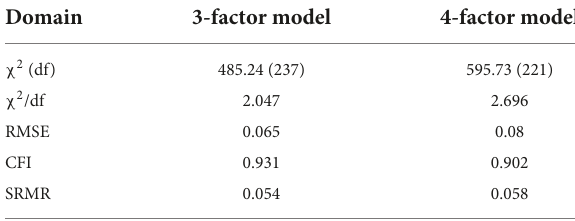
TABLE 3 Goodness-of-fit indices of 3-factor model and 4-factor model. Domain